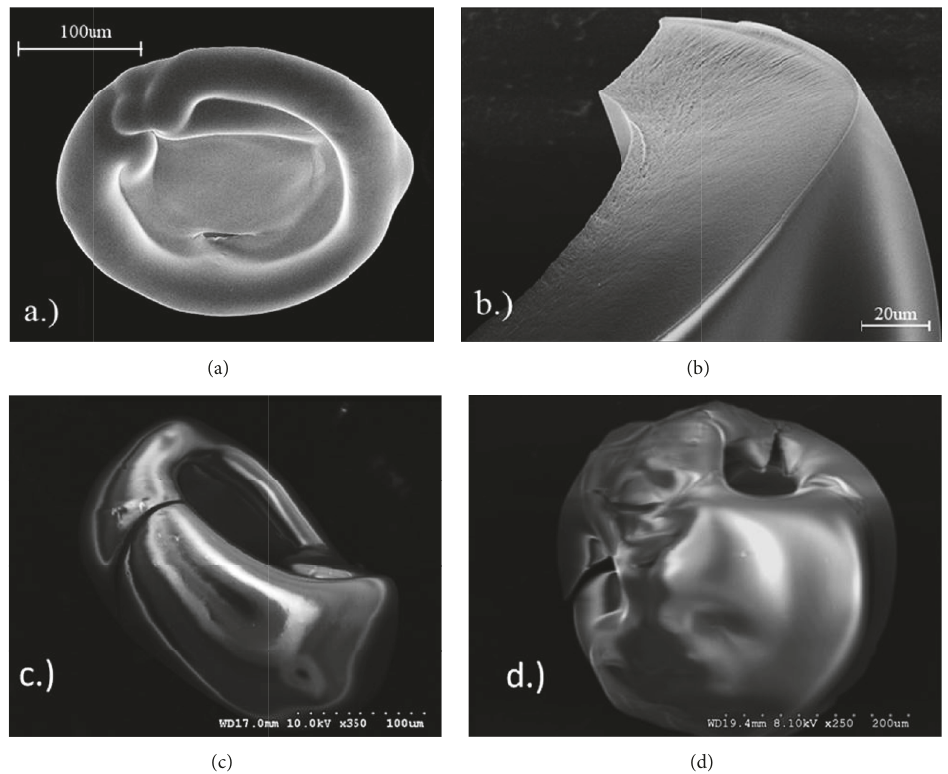
Figure 9: Different residues obtained from levitating droplets (reproduced from [66], with the permission of AIP Publishing).